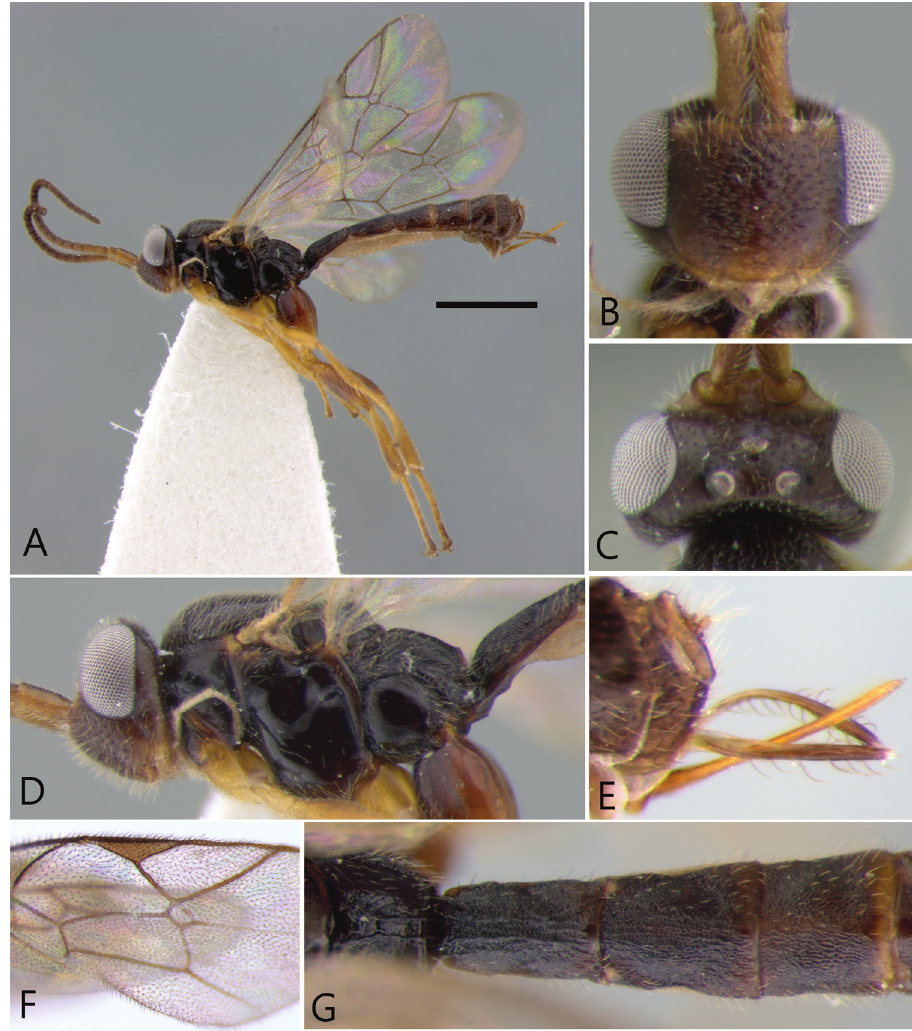
Figure 3. Orthocentrus caudalis sp. nov. Holotype. A Habitus in lateral view B head in frontal view C head in dorsal view D head and mesosoma in lateral view E ovipositor F areolet G propodeum and first to third tergites in dorsal